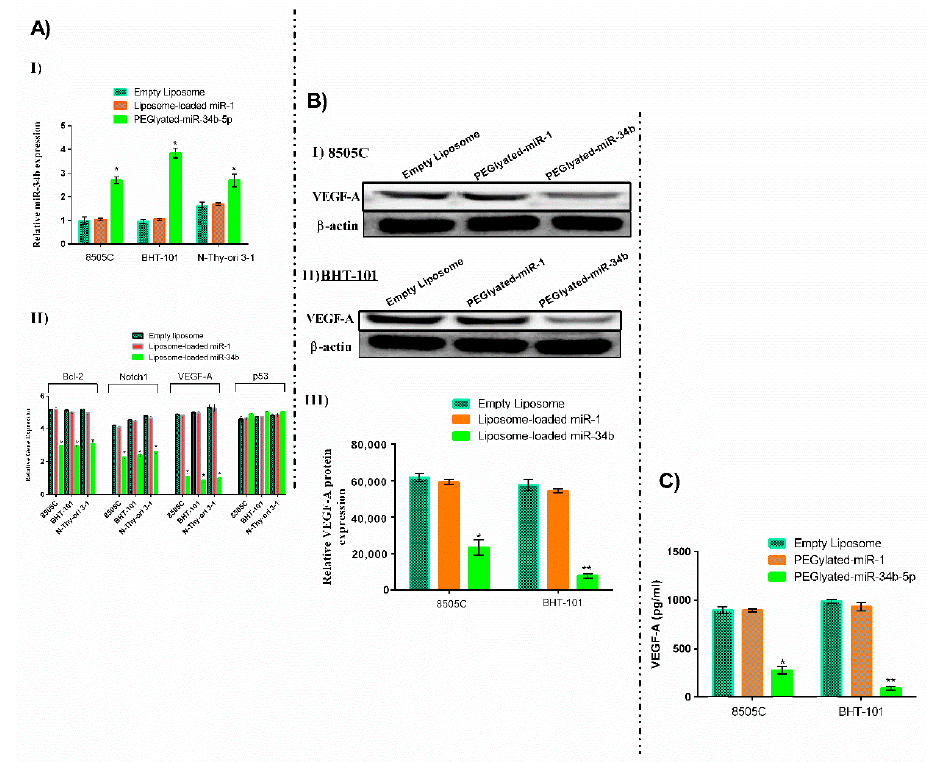
Figure 1. The effects of miR ‐ 34b overexpression on VEGF ‐ A expression in 8505C, BHT ‐ 101 and N ‐ thy ‐ ori 3 ‐ 1 cells. ( A ) (I) After two days, relative miR ‐ 34b expression after transfection with liposome ‐ loaded miR ‐ 34b, liposome ‐ loaded miR ‐ 1 and empty liposome, detected by qRT ‐ PCR. Liposome ‐ loaded miR ‐ 34b transfection led to overexpression of miR ‐ 34b in anaplastic thyroid carcinoma